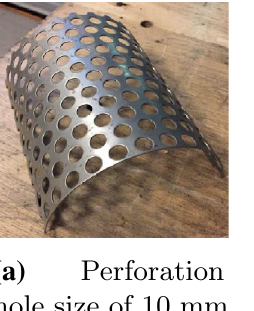
(c) Perforation hole size